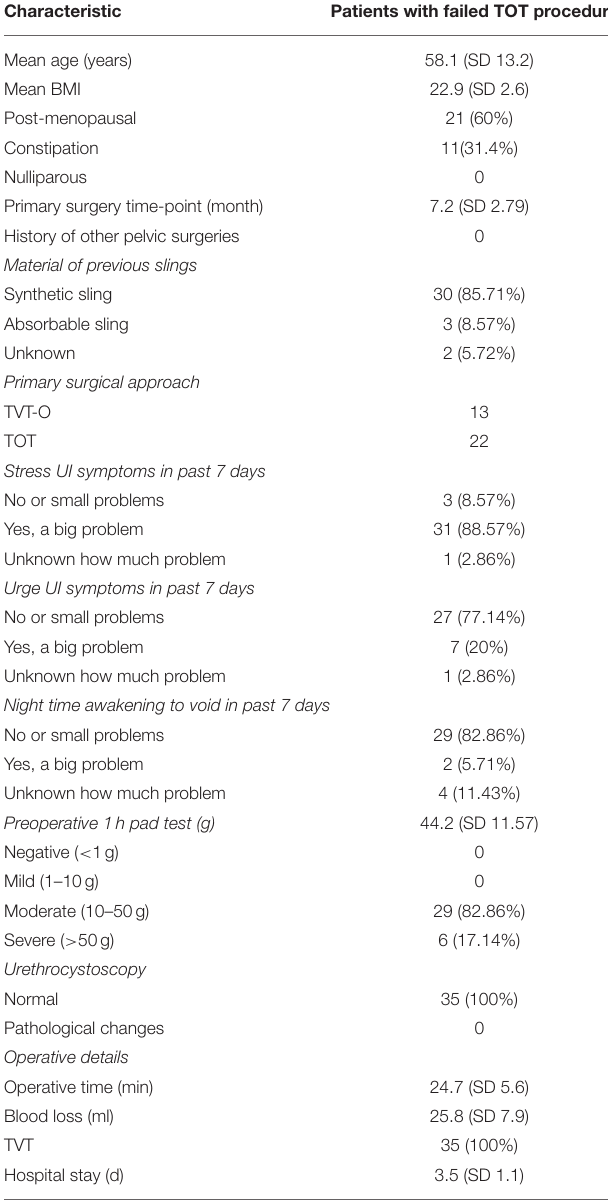
TABLE 1 | Patient characteristics, operative details, and hospital stay. Characteristic Patients with failed TOT